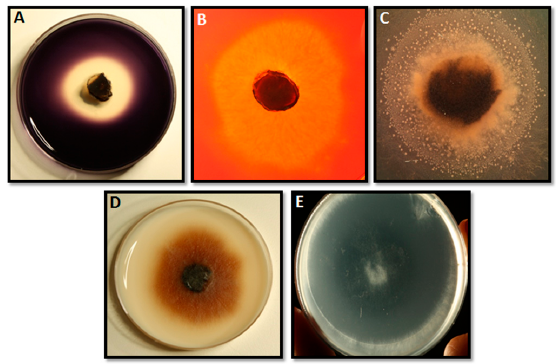
Figure 1. Images showing positive results of extracellular enzymatic activity of all types of enzymes tested. ( A ) amylases, ( B ) cellulases/xylanases, ( C ) lipases, ( D ) laccases, ( E ) proteases.